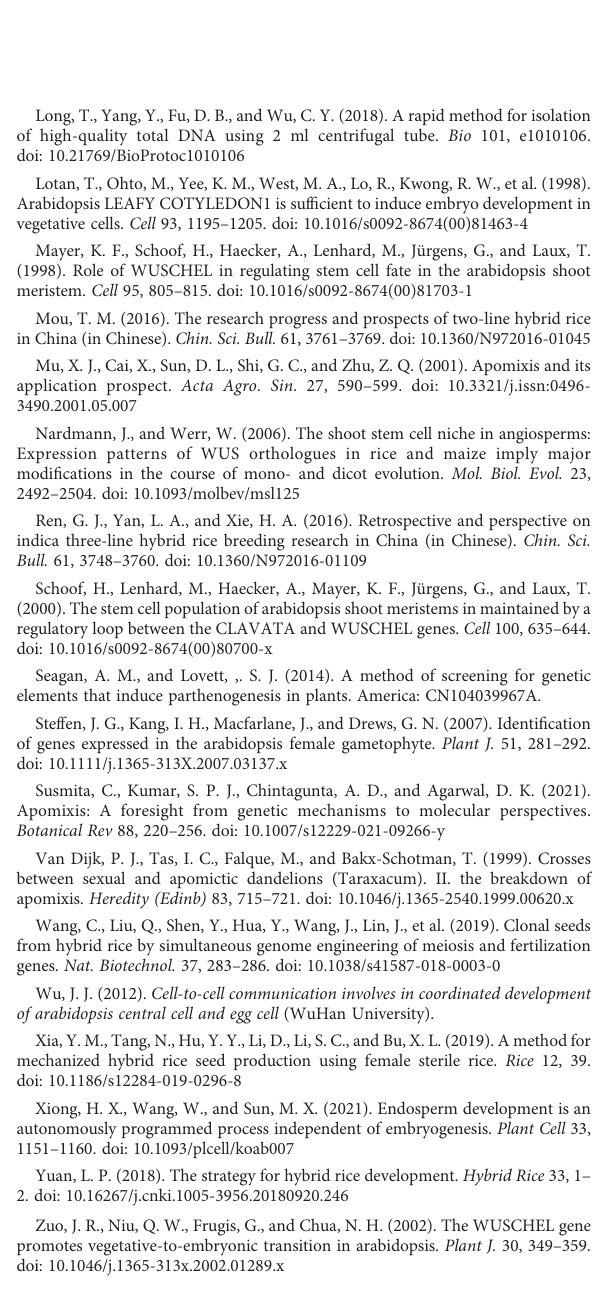
Detecting the exogenous gene in transgenic